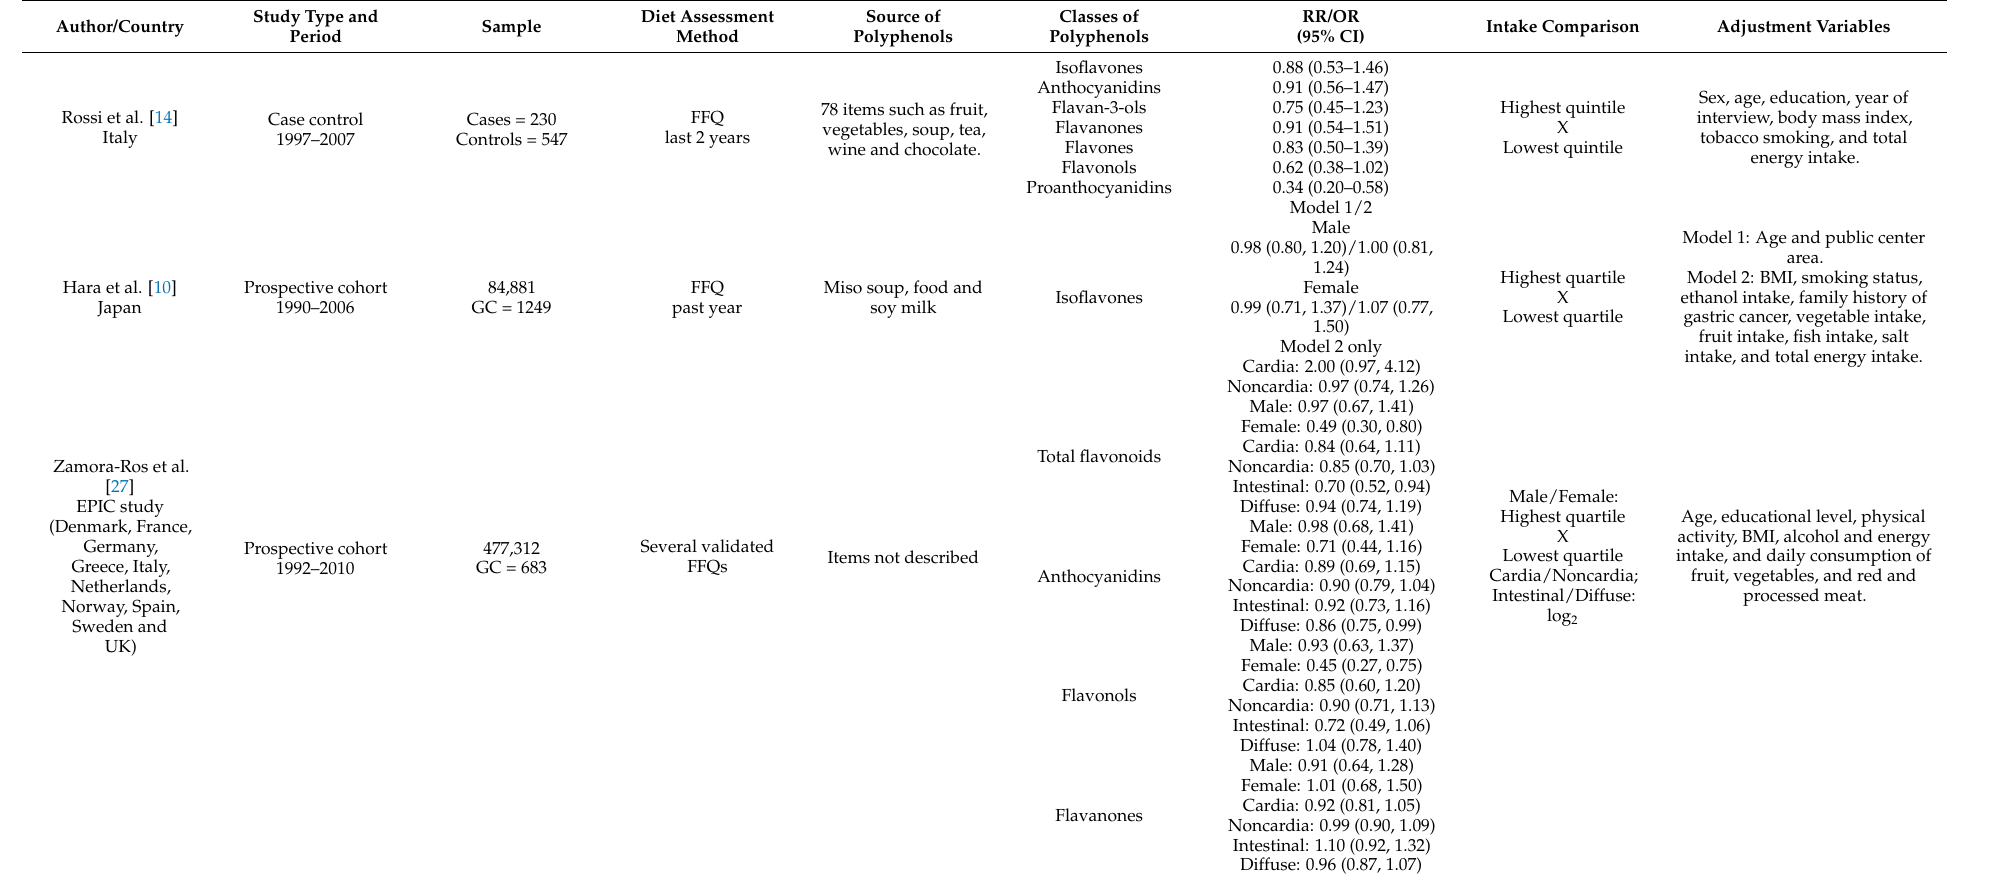
Model 2: BMI, smoking status, ethanol intake, family history of gastric cancer, vegetable intake, fruit intake, fish intake, salt intake, and total energy